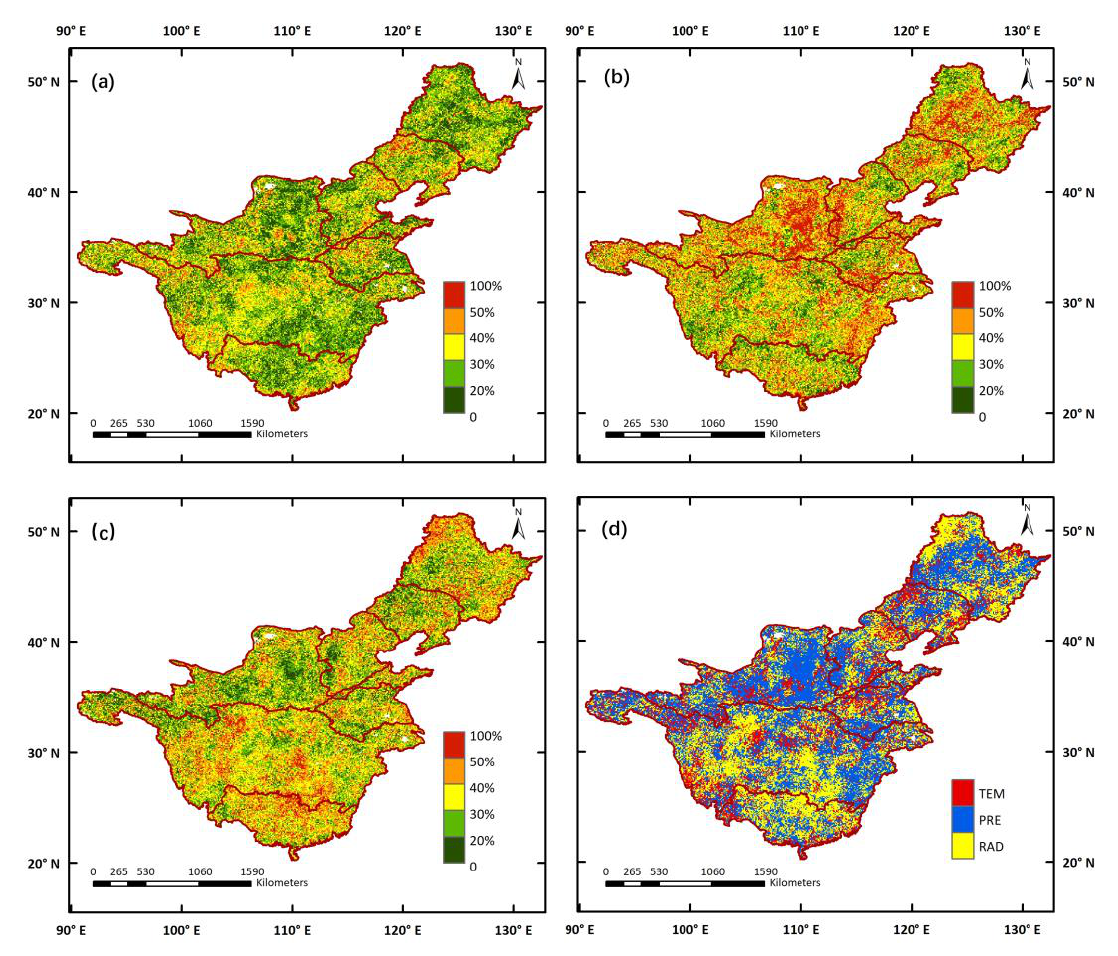
Figure 8. Spatial distributions of Vegetation Sensitivity Index (VSI) in seven major watersheds during 1982 – 2015.